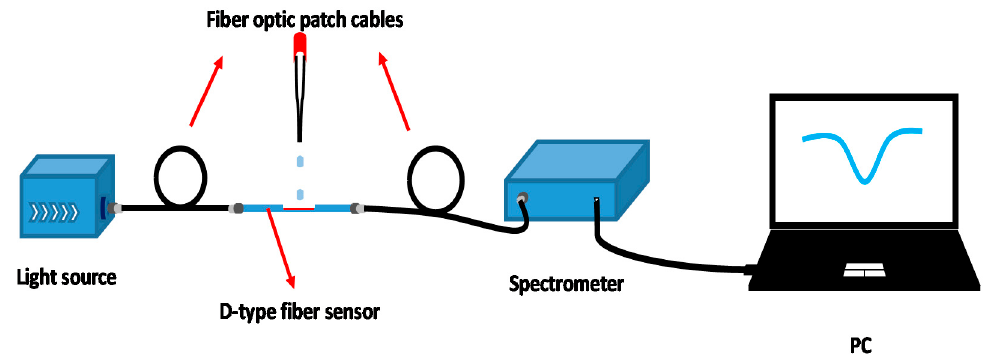
Figure 2. The diagram for the experimental device used in the D-type fiber optic biosensor with Au- Au-graphene graphene structure.